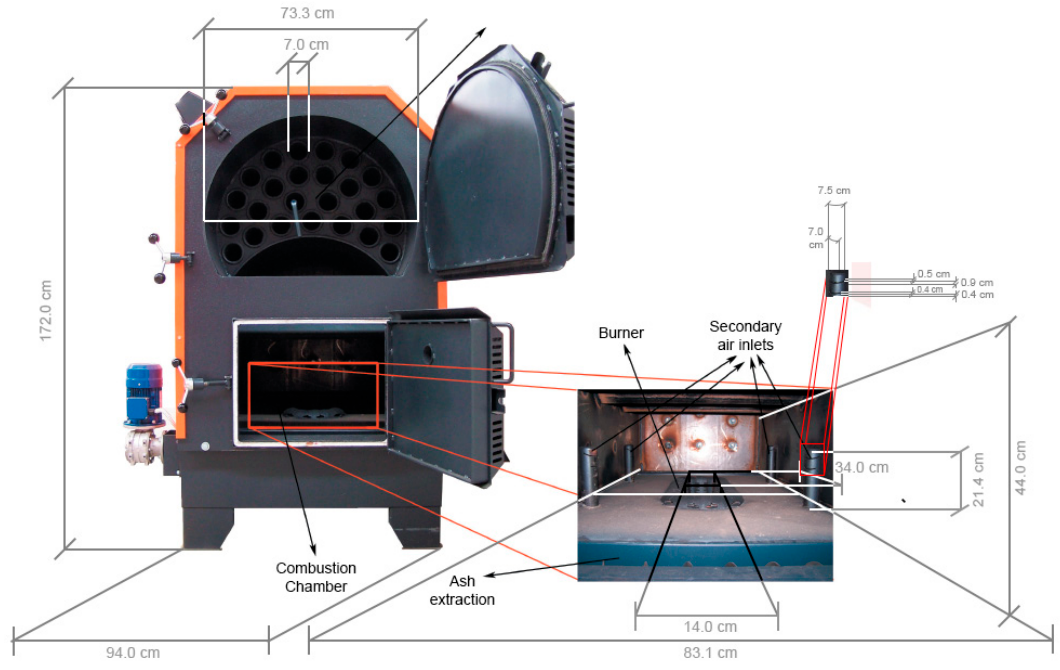
Figure 4. Biomass boiler, combustion chamber, and dimensions.